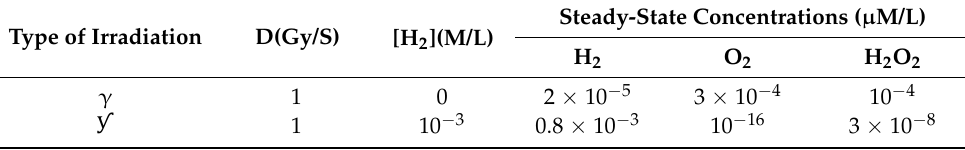
Table 15. Effect of added hydrogen on the predicted concentrations of H 2 , O 2 , and H 2 O 2 . (after Kritsky et al. [27]).